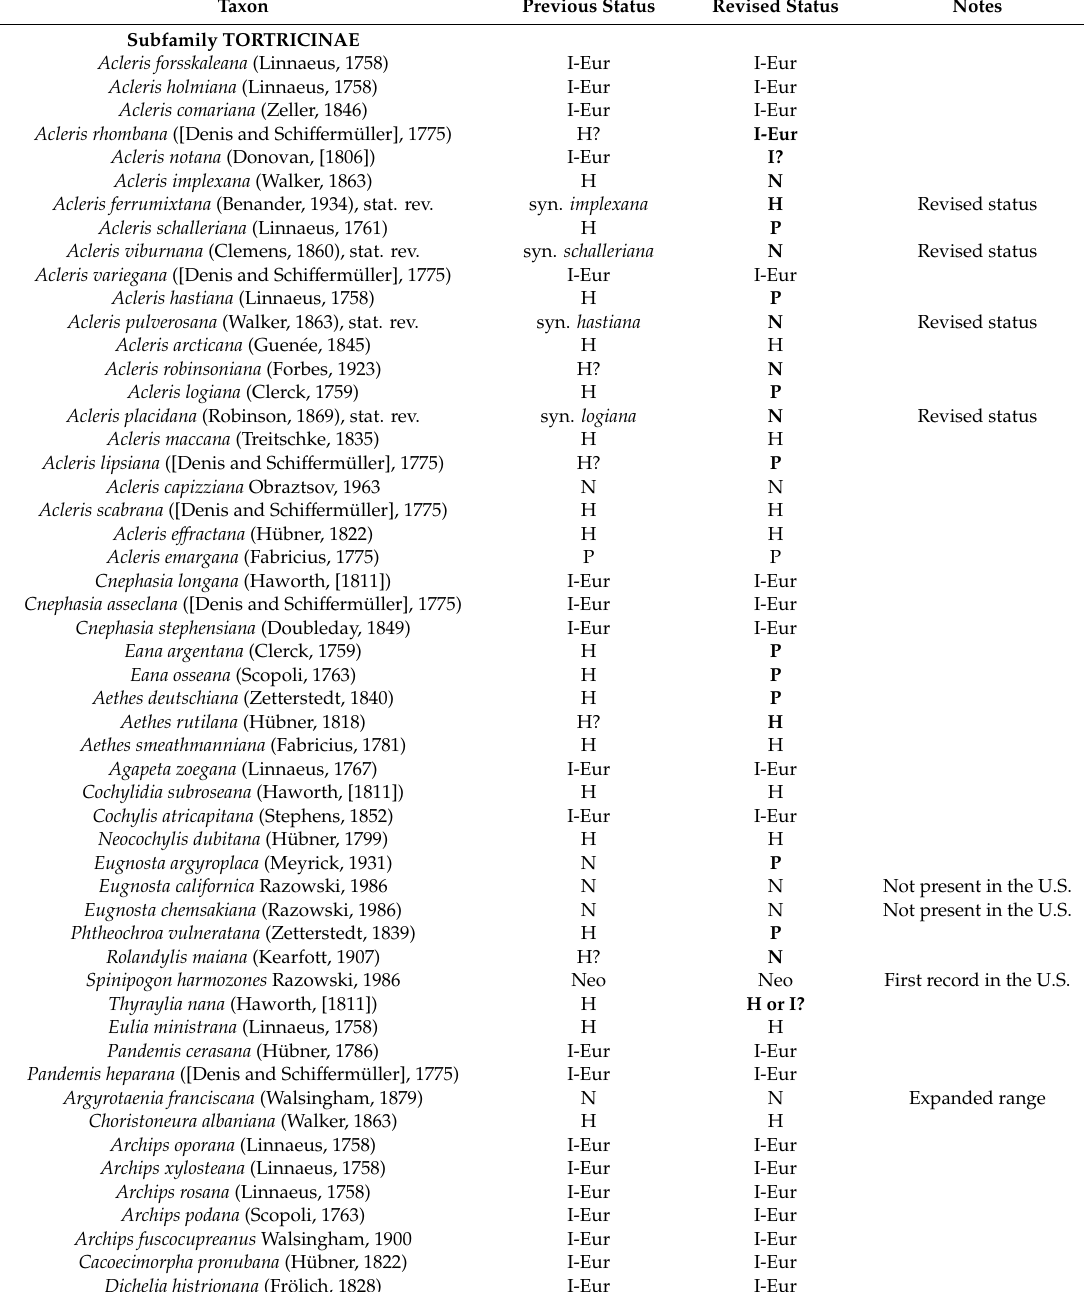
Table 1. Summary of immigrant Tortricidae and their previous and current status. Changes of status are noted in bold (Afro = Afrotropical; Aust = Australia; Eur = Europe; H = Holarctic; I = Introduced; N = Nearctic; Neo = Neotropical; P =